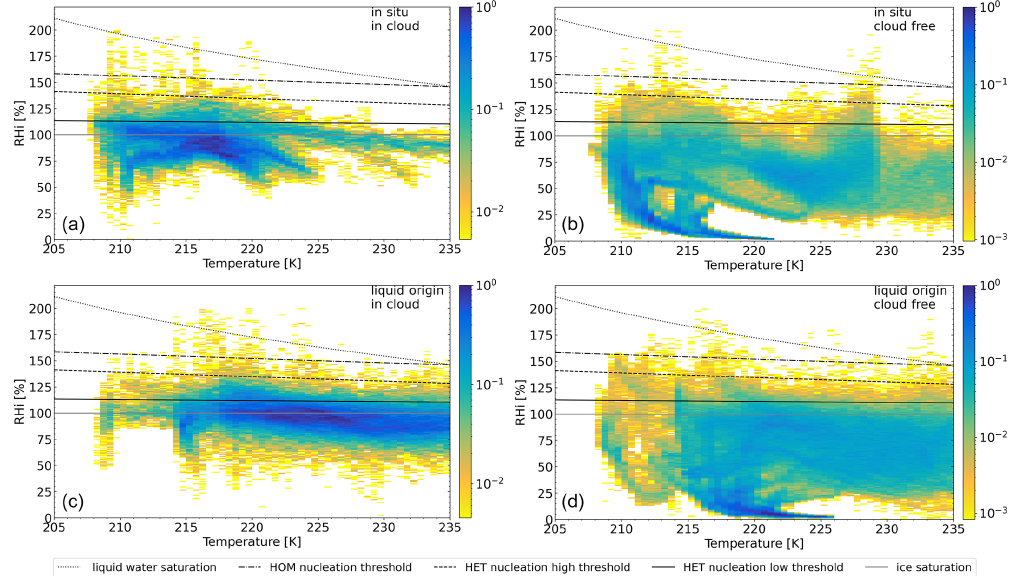
Figure 4. PDFs of RHi with respect to ambient temperature. (a) In situ in-cloud data points. (b) In situ cloud-free data points. (c) Liquid- origin in-cloud data points. (d) Liquid-origin cloud-free data points. For an in-detail explanation see Fig. 2.